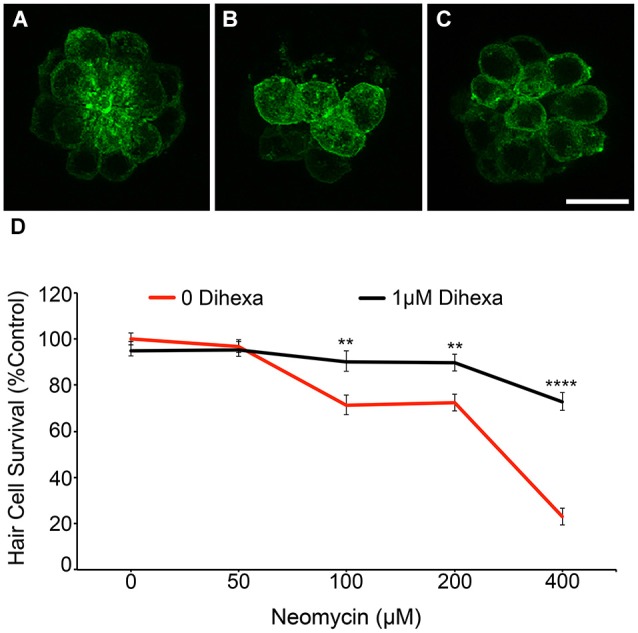
Dihexa treatment prevents neomycin-induced hair cell loss in Brn3c:mGFP transgenic larvae. (A) DMSO-treated control, (B) 400 μM neomycin treated neuromast shows a reduction in hair cells, and (C) neuromasts treated with 1 μM Dihexa plus 400 μM neomycin remain mostly intact. (D) 1 μM Dihexa provides protection from neomycin-induced hair cell loss across the neomycin dose-response curve (Two-way ANOVA; Dihexa: F(1,456) = 50.77 p < 0.001). Asterisks indicate significant difference from neomycin control (**p < 0.01, ****p < 0.001). N = 8–10 animals per treatment, error bars represent ± s.e.m.